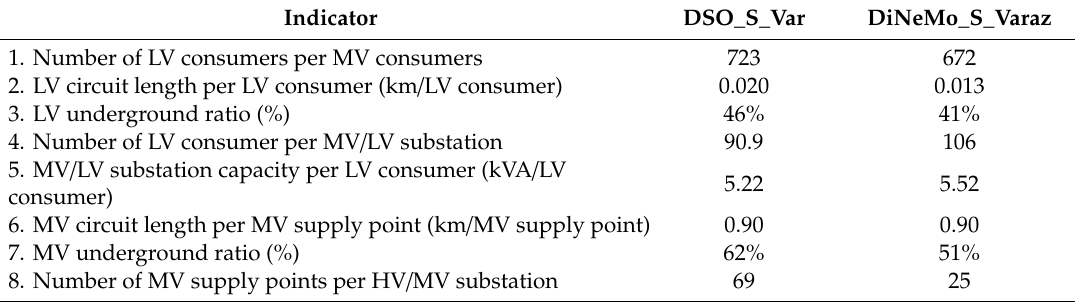
Table 5. Comparison of indicators for industry area.